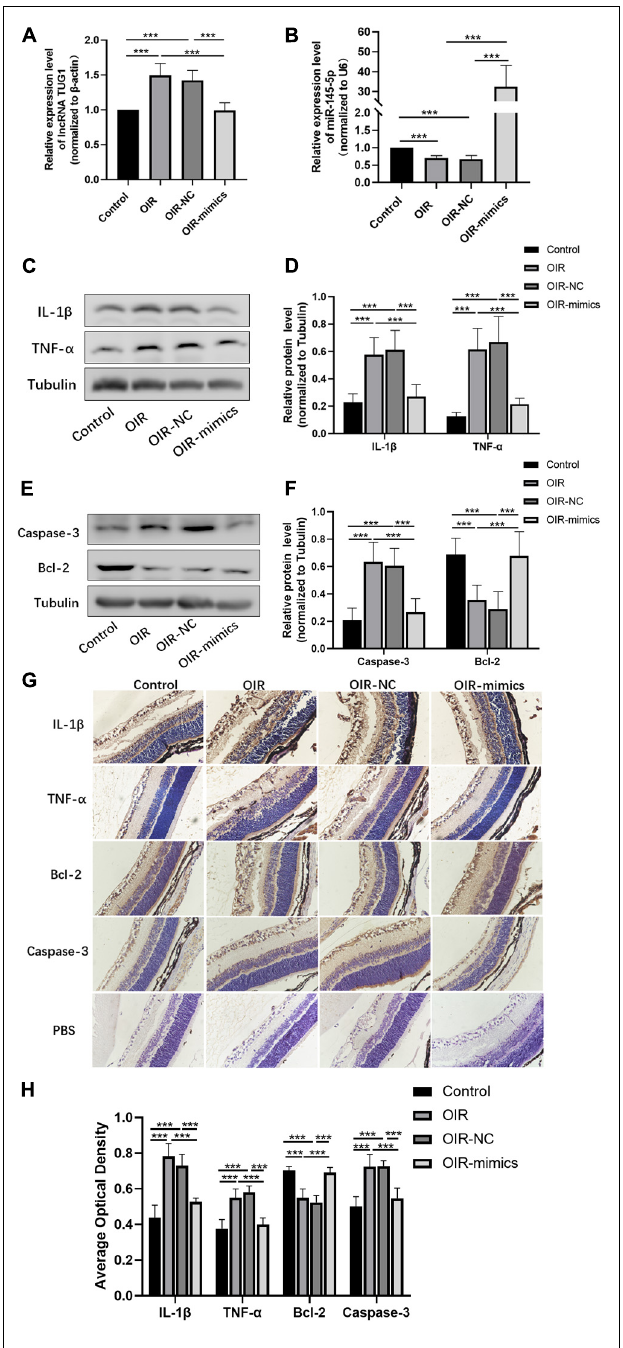
FIGURE 7 | Overexpression of miR-145-5p inhibits inflammation and apoptosis in OIR retinal tissue. (A) Tug1 expression level (mean ± SD, n = 6), *** P < 0.001. (B) MiR-145-5p expression level (mean ± SD, n = 6), *** P < 0.001. (C) Western blot results of IL-1 β , and TNF- α expression. (D) Quantitative analysis of band intensities in (C) (mean ± SD, n = 7). *** P < 0.001. (E) Western blot results of caspase-3, and Bcl-2 expression. (F) Quantitative analysis of band intensities in (E) (mean ± SD, n = 7). *** P < 0.001. (G) Immunohistochemical map of IL-1 β , TNF- α , Bcl-2, and caspase-3 in the retinal tissues of each group. (H) The average optical density of the immunohistochemical map in different treatment groups (mean ± SD, n = 7). *** P <